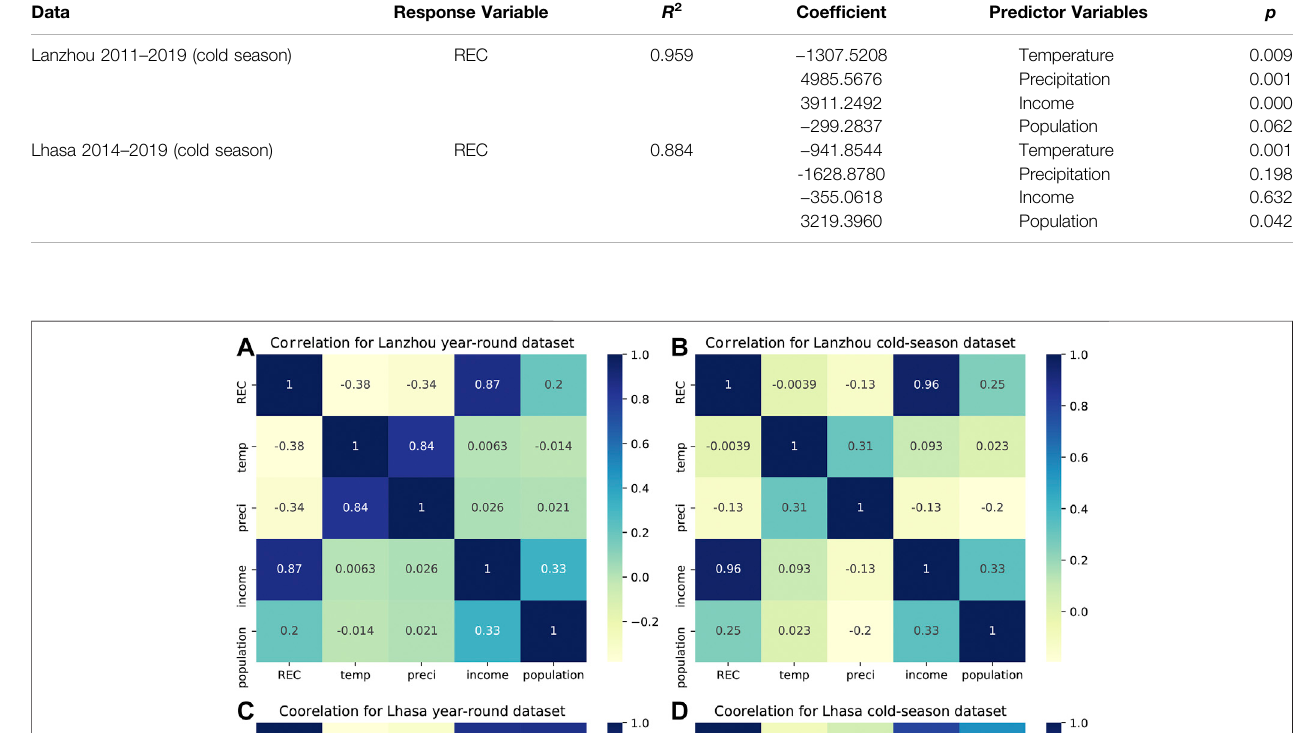
TABLE 2 | Results of ordinary least squares (OLS) linear regression modeling of the Lanzhou and Lhasa cold-season data subsets. (REC - residential electricity consumption). Data